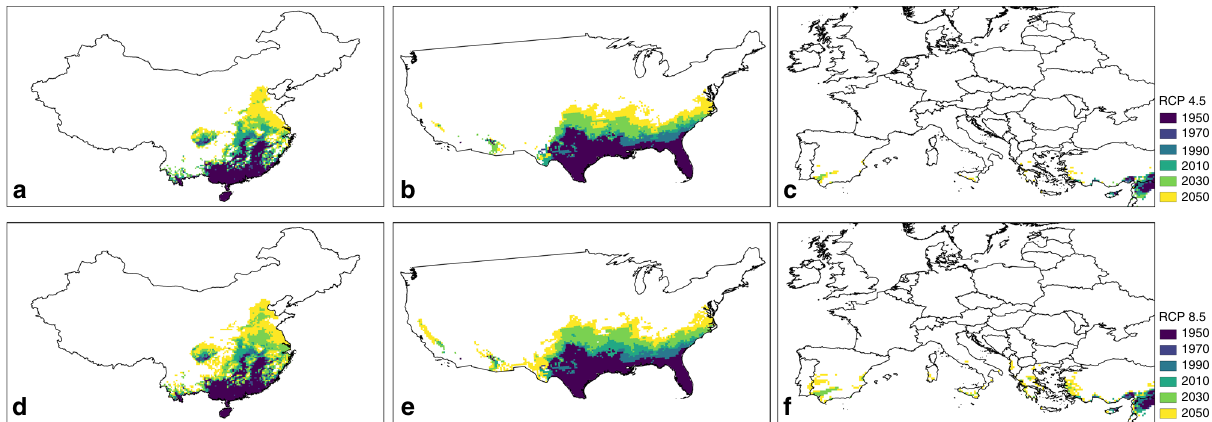
Fig. 4 Expansion of invasion frontiers of Ae. aegypti in China, USA and Europe from 1950 – 2050 under RCPs 4.5 and 8.5. Invasion frontiers of Ae. aegypti were estimated at decadal intervals for China, USA and Europe based on LCC predictions. The frontier threshold was set at ≥ 10 LCC based on the frequencies of LCC values extracted to the historical occurrence records of Ae. aegypti . The colour scheme represents the frontier contour lines in separate decadal intervals (1950, 1970, 1990, 2010, 2030 and 2050). Shifts in the invasion frontiers are shown for: ( a ) China under RCP 4.5, ( b ) USA under RCP